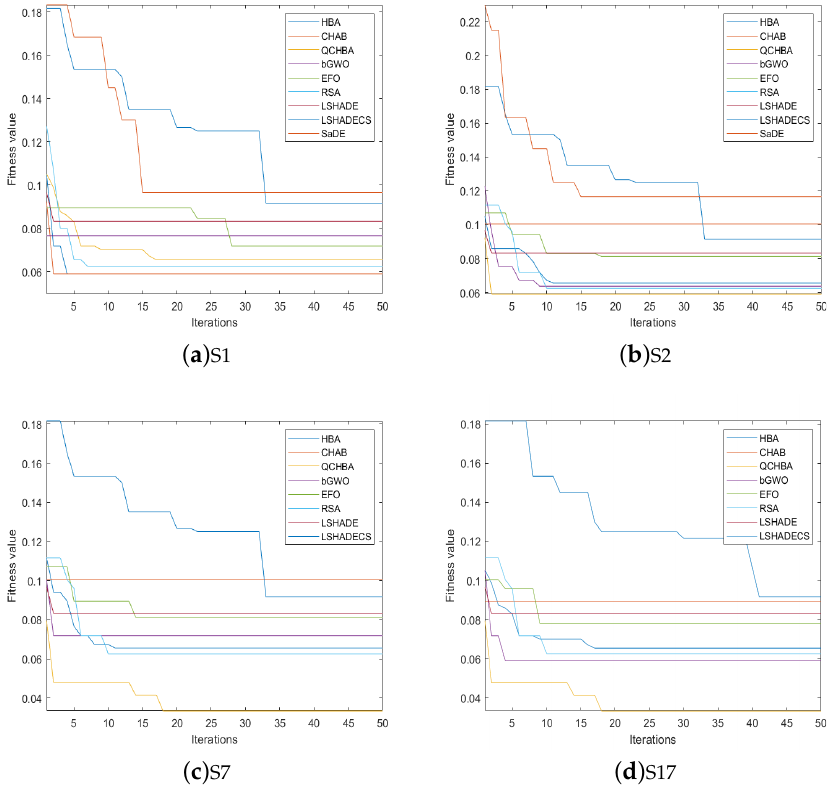
Figure 6. The convergence curve of the competitive algorithms for S1, S2, S7, and S17. Figure 6. Convergence curves of the competitive algorithms for S1, S2, S7, and